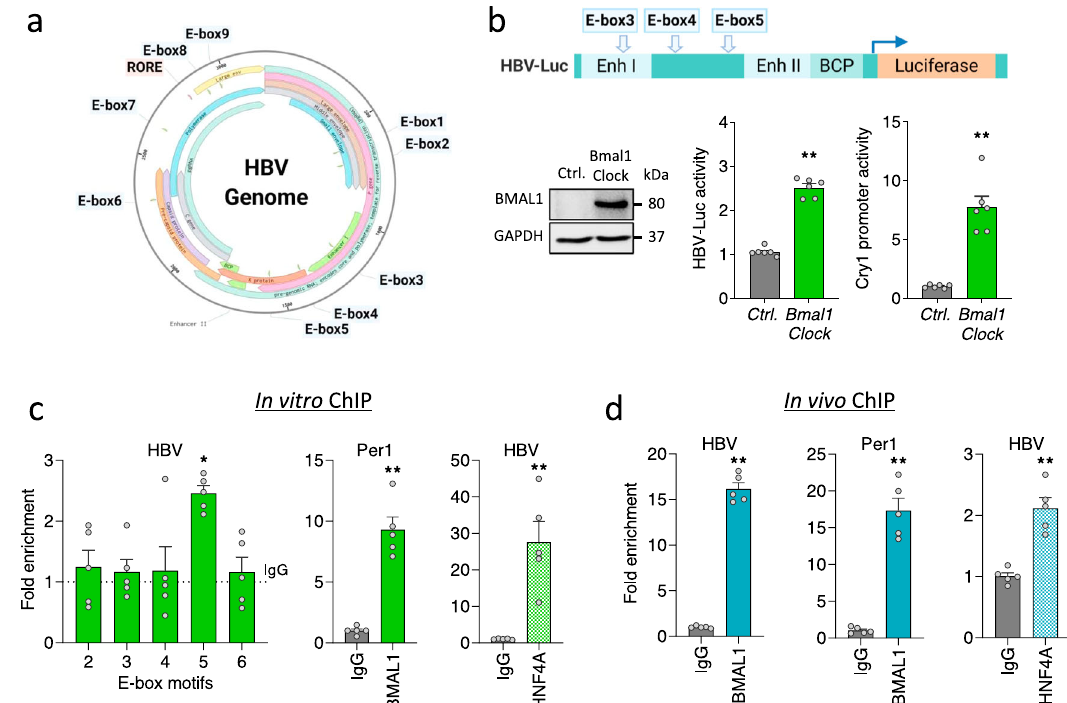
Fig. 5 BMAL1 regulates HBV transcription by direct binding to the viral genome. a E-box and RORE motifs in the HBV genome (Genotype D,